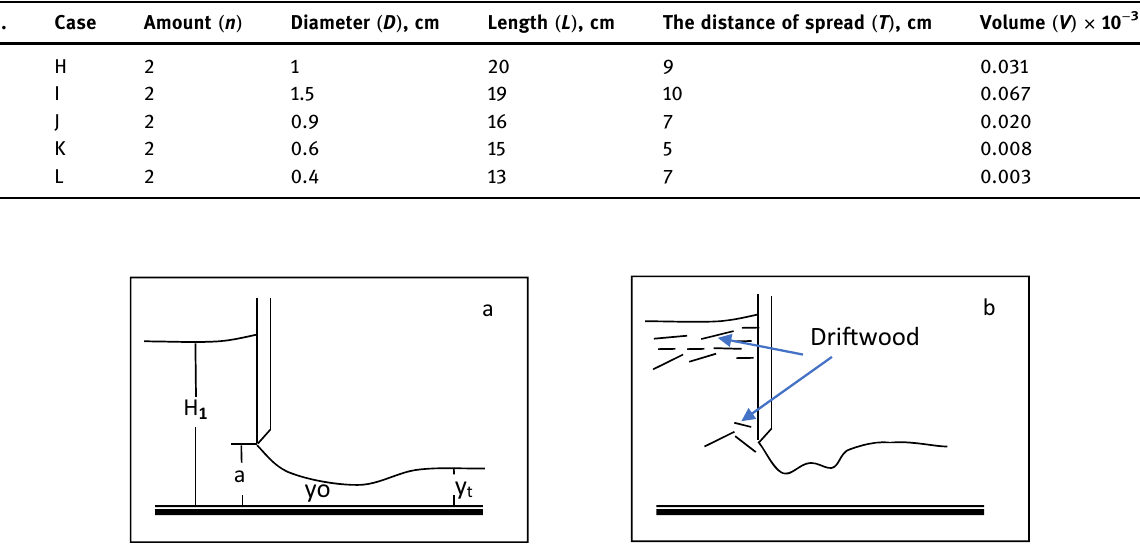
Table 2: Wooden rootstock dimensions